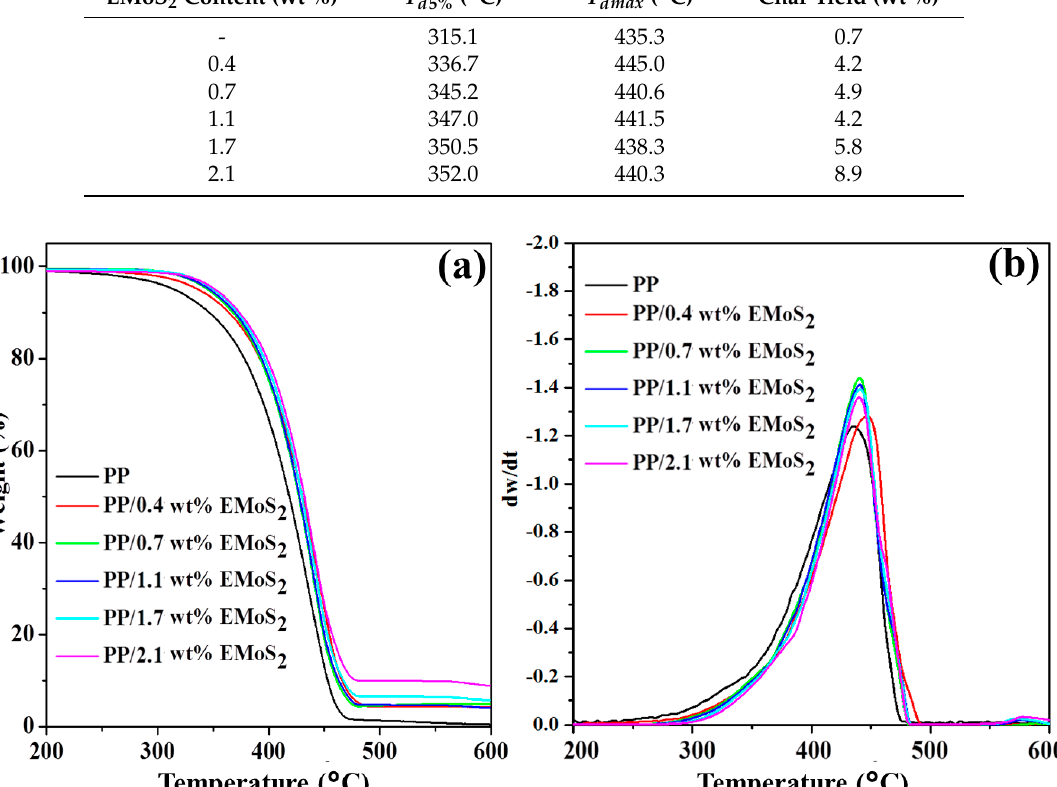
Figure 6. TGA ( a ) and DTG ( b ) curves of PP and PP/EMoS 2 nanocomposites.